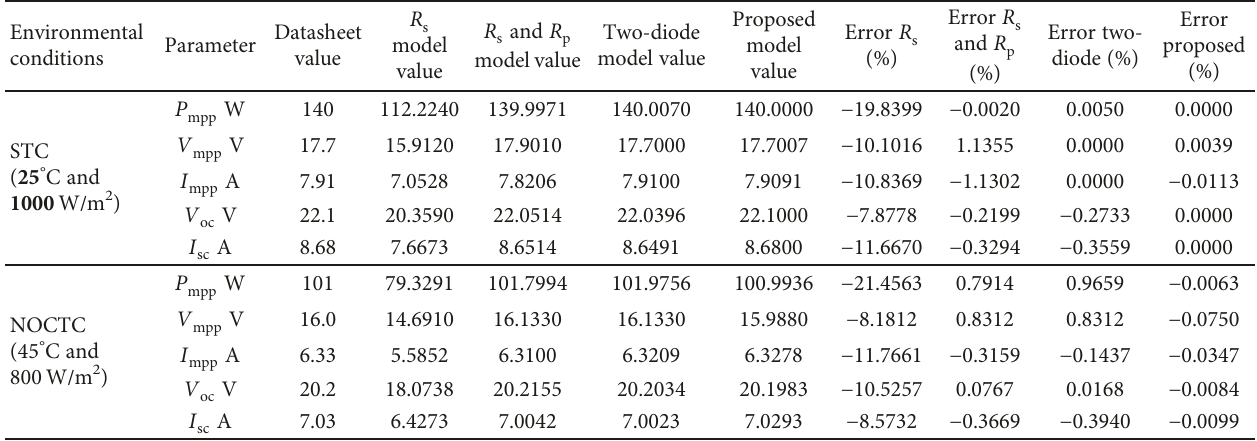
Table 7: Comparison of R KD140GX-LFBS PV module [34].